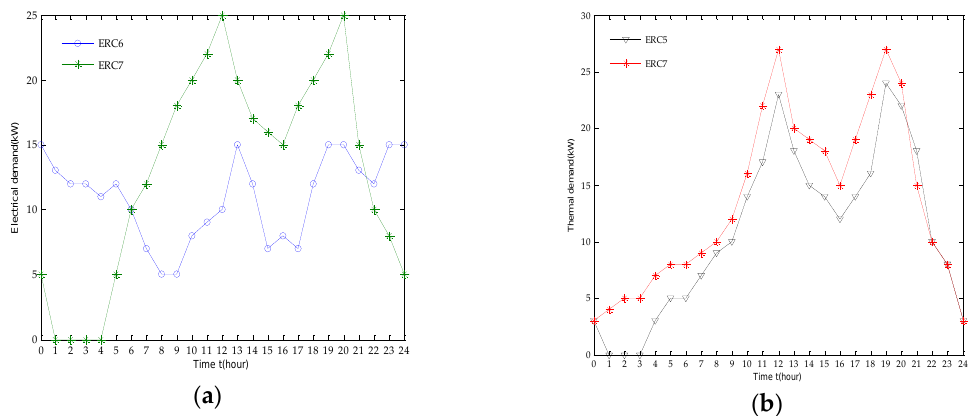
Figure 6. Users’ demands in a single day. ( a ) Electrical power demands of ERC6 and ERC7; ( b ) heat demands of ERC5 and ERC7.